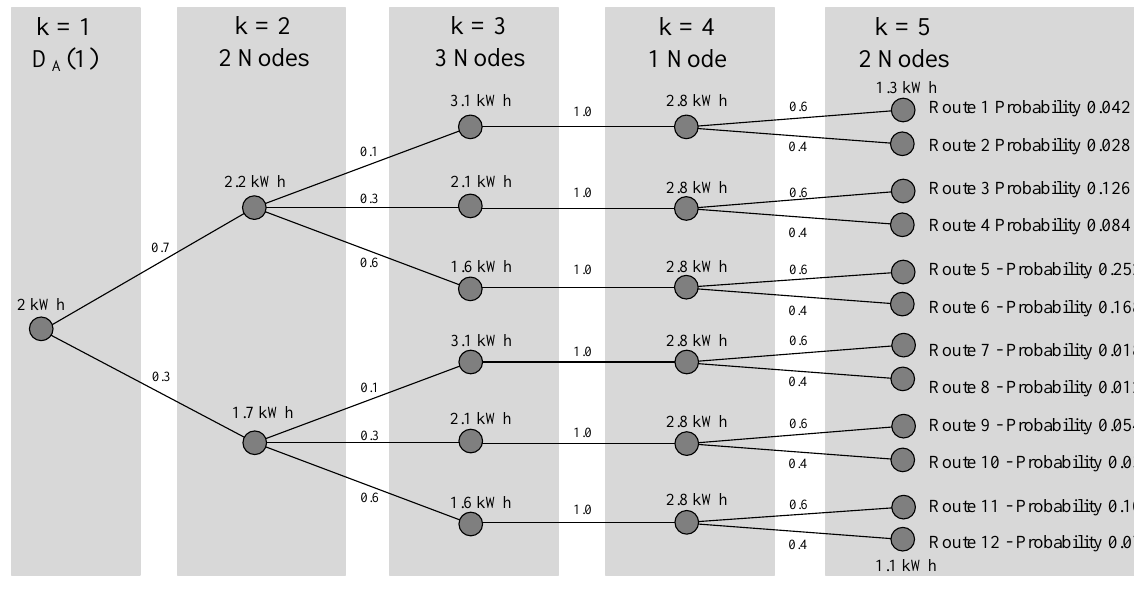
Figure 3. A scenario tree of five time steps with a varying number of nodes per time step. The probabilities of a specific node occurring are shown, as is the probability of the complete route occurring.